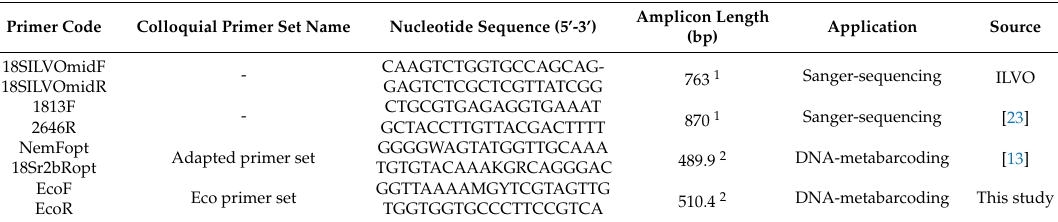
Table 2. Information on the primers used in this